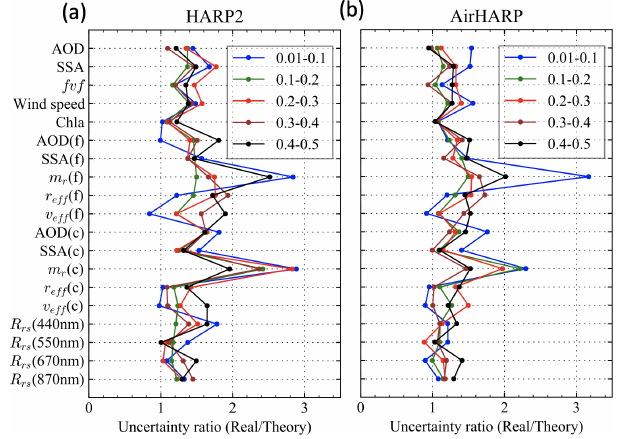
Figure 9. Ratio of real to theoretical retrieval MAE for the data shown in Fig. 8. Chl a is in terms of MAE ( log ) as defined in Eq.